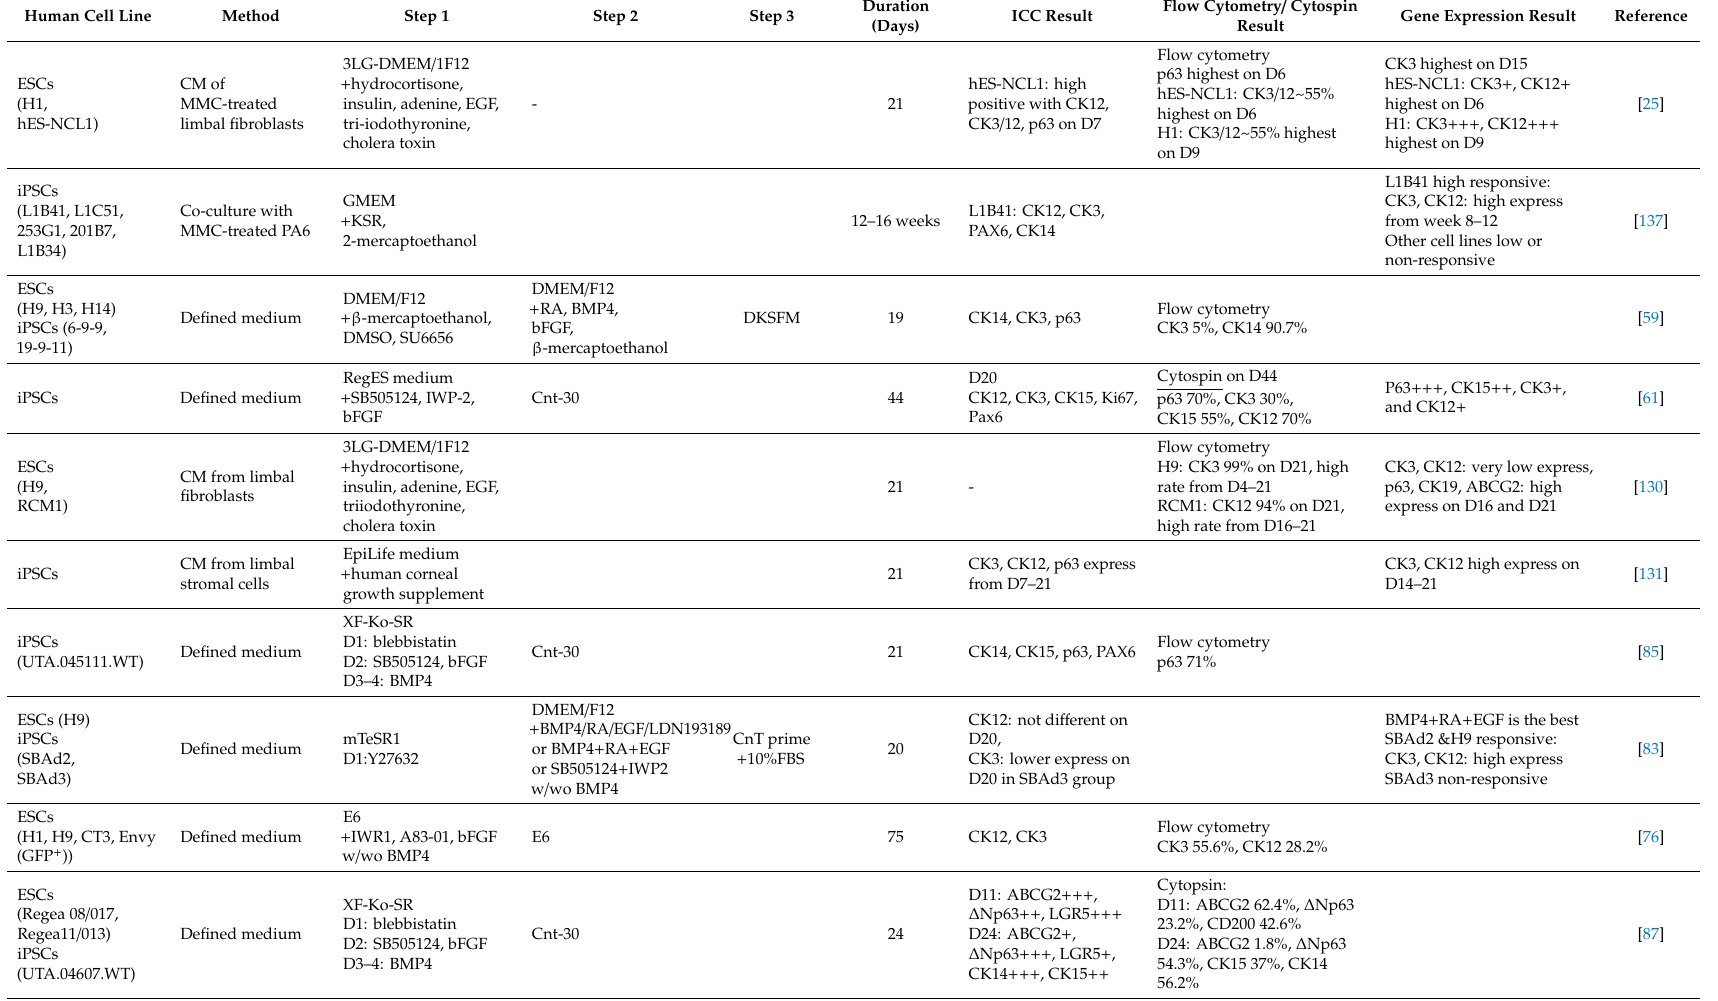
Table 3. Corneal epithelial di ff erentiation of human